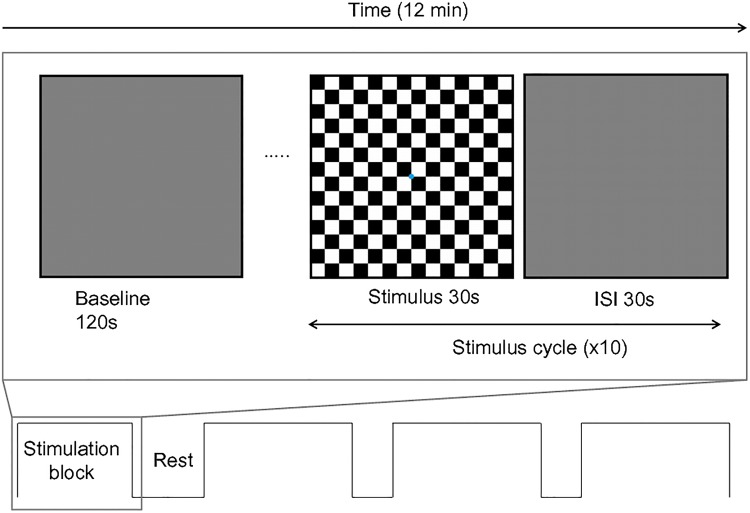
Experimental protocol showing baseline recording and cycles of visual stimulation, repeated 10x per condition.